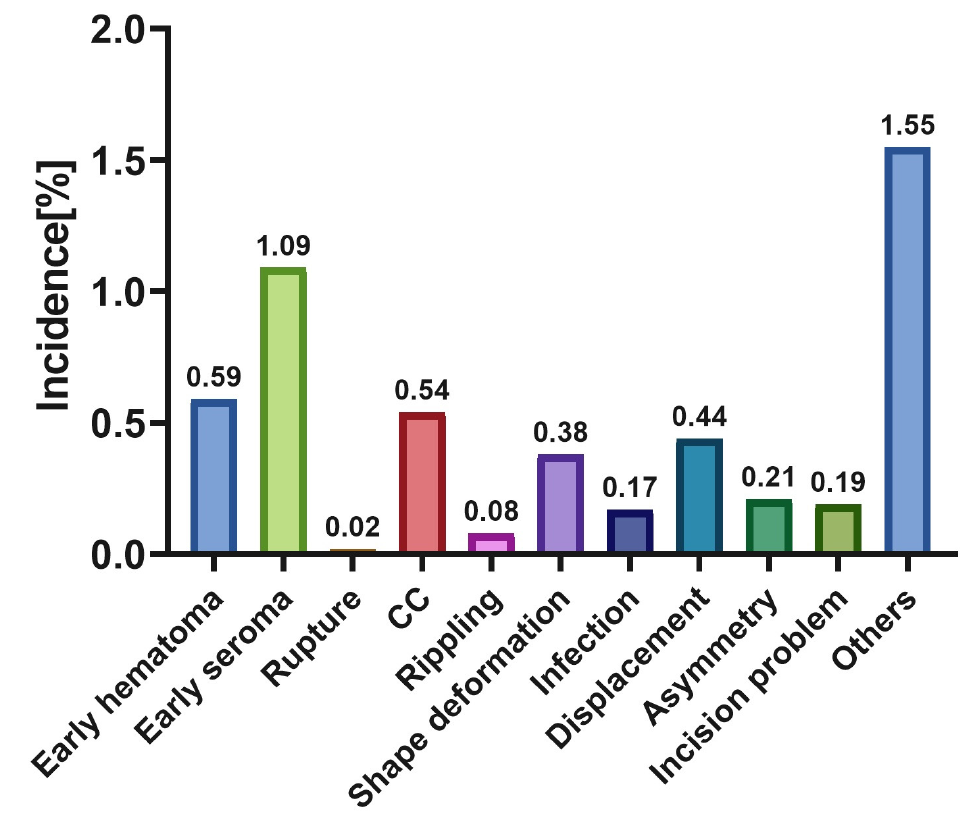
Figure 5. The total incidence of complications.